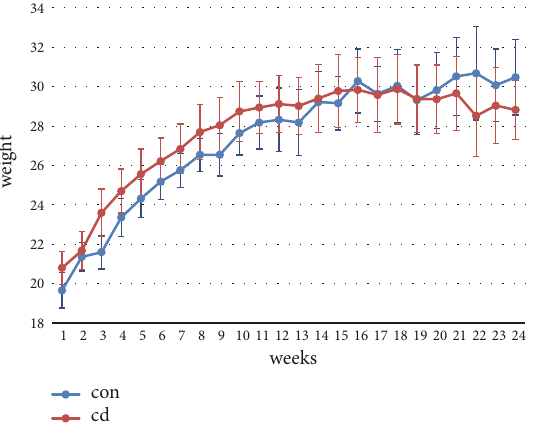
Figure 1: Effects of Cd (cadmium chloride; 1 mg.kg −1 , intraperitoneal injection, twice weekly) on body weights in male C57BL/6 mice. Cd exposure had no significant effect on body weight in male C57BL/6 mice, n=5/group.